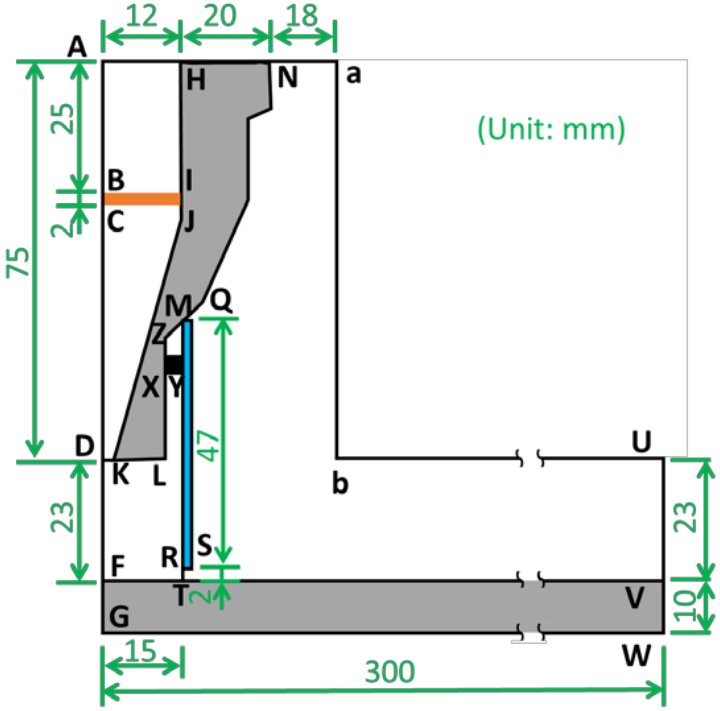
Figure 1. Scheme of the computing model for APPJ. Table 1. Setting of the computing model domains.